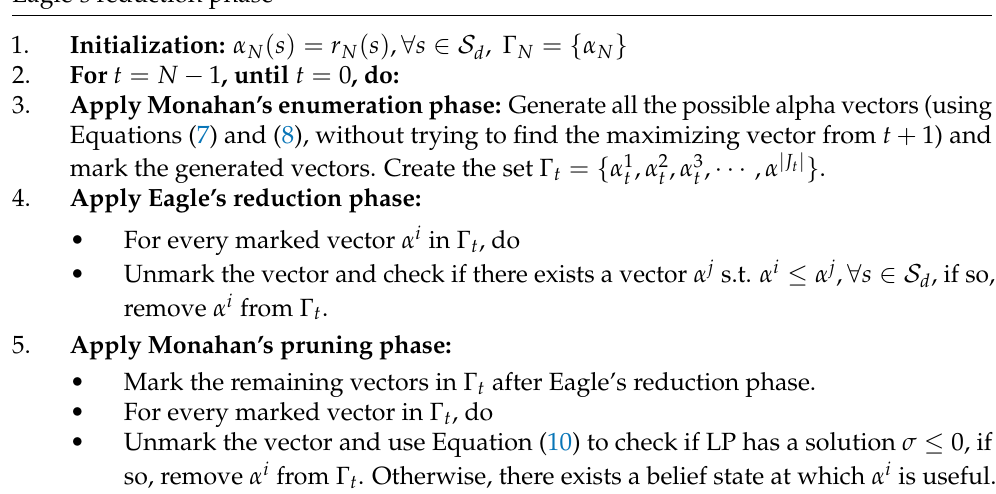
Algorithm 1 Compact representation of solution method with Monahan’s algorithms and Eagle’s reduction